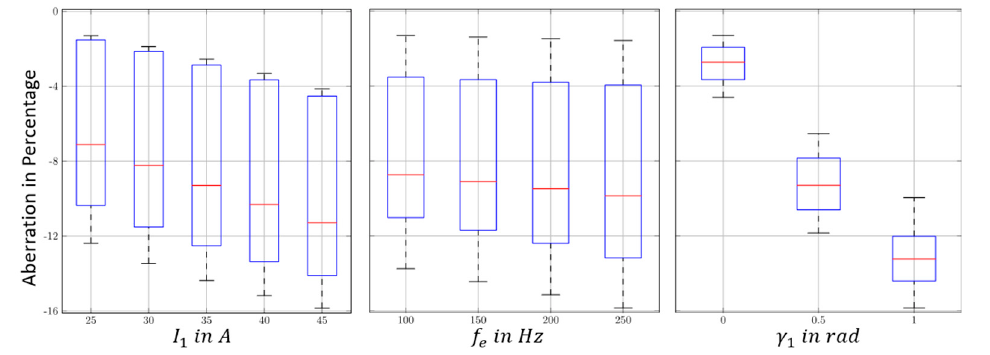
Figure 3. Distribution of the key indicator, e fund for the constant torque value